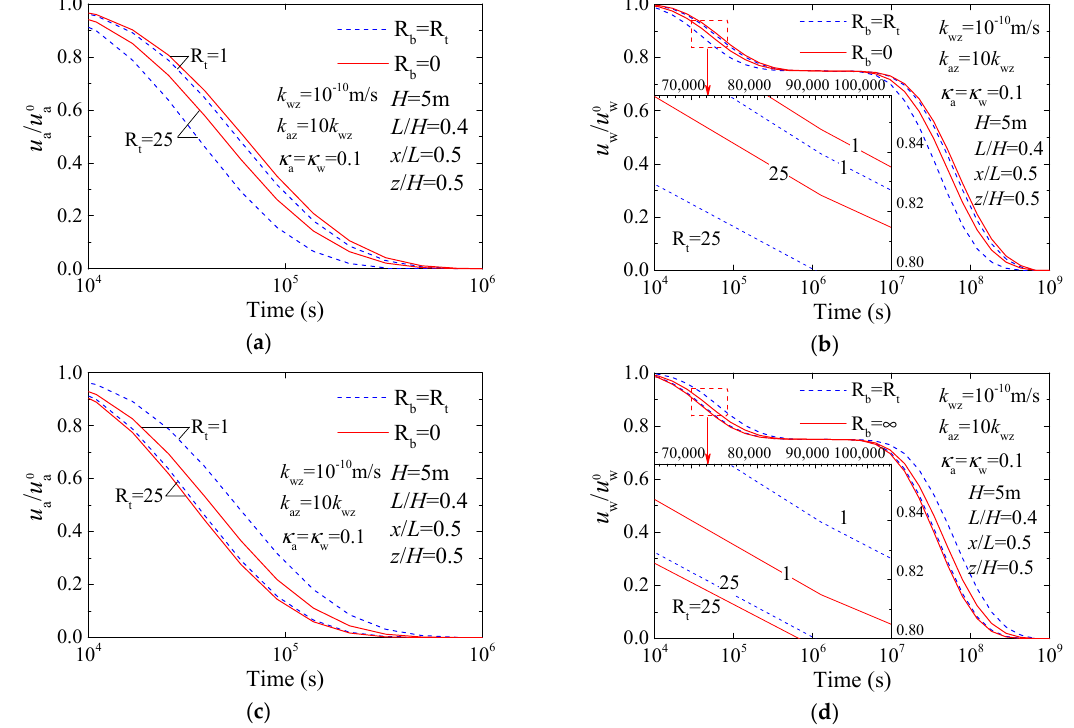
Figure 7. Variations of excess pore-pressures under asymmetrical vertical impeded drainage boundary with different drainage efficiencies: ( a,b ) R b = 0 and ( c,d ) R b = ∞ .